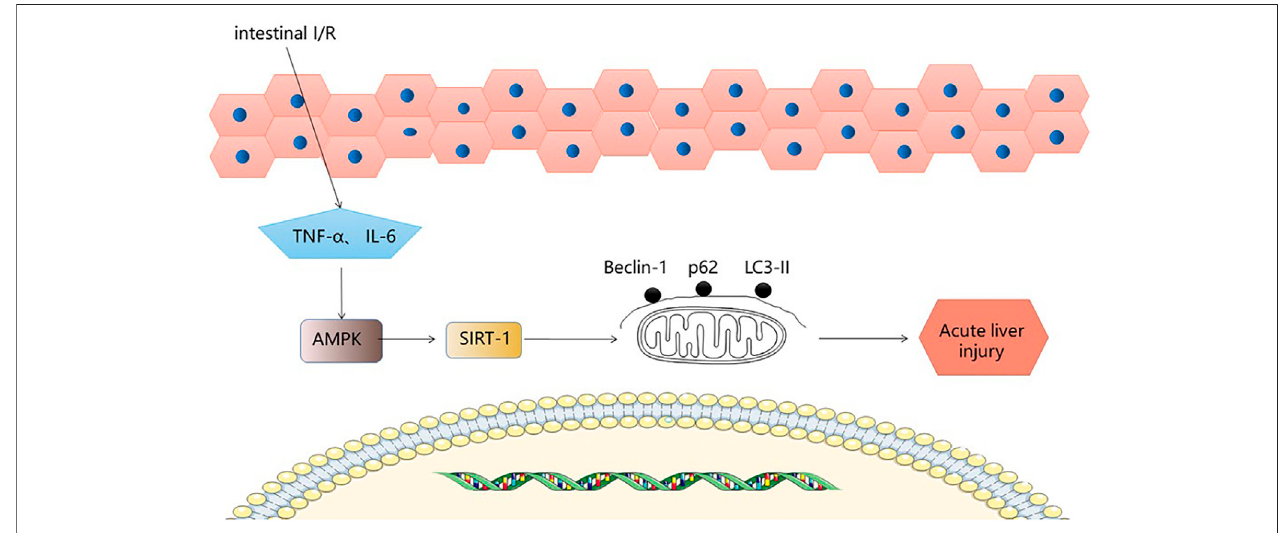
FIGURE 5 | AMPK-SIRT-1 signaling